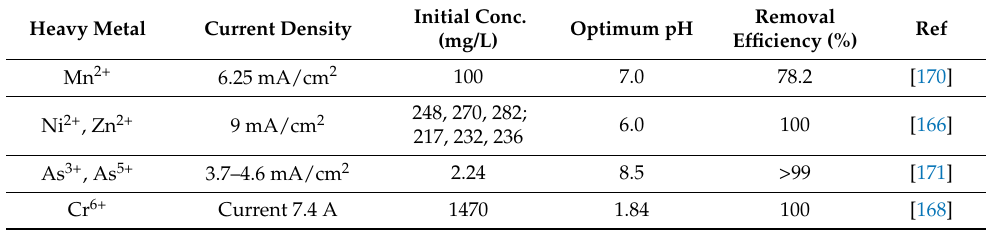
Table 7. Heavy metal removal by EC method [169]. Reproduced with permission from Fu, F.; Wang, Q., Removal of Heavy Metal Ions from Wastewaters: A Review, published by Academic Press,